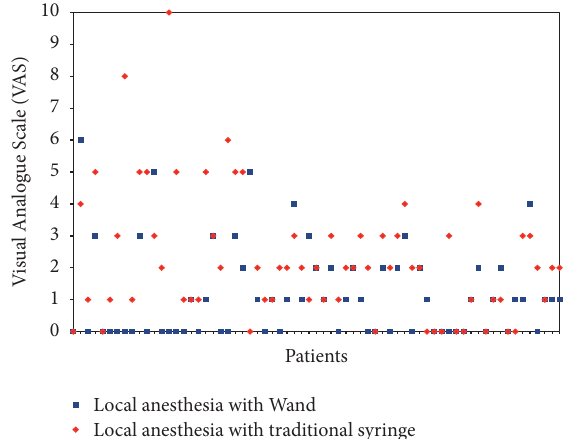
Figure 1: Score on Visual Analogue Scale (VAS) during local anesthesia. 38 of the 67 patients found the injection with the traditional syringe (red) to be more painful than the injection with the Wand (blue), while 12 found the injection with the Wand to be more painful than the injection with the traditional